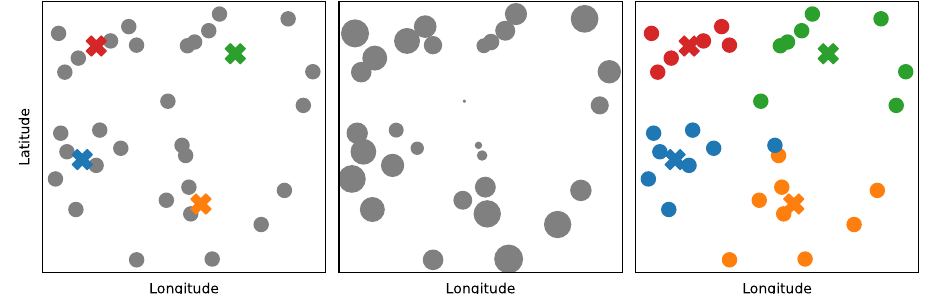
Fig. 5 Example clustering of N = 30 patients into clusters of D = 8. Left: initialisation of four cluster centroids (denoted with crosses). Centre: order of patient assignment, where larger circles indicate priority assignment and will be dealt with fi rst. Patients in the centre of the distribution could be assigned to any cluster with low cost, so are dealt with last. Right: the optimal clustering of patients after